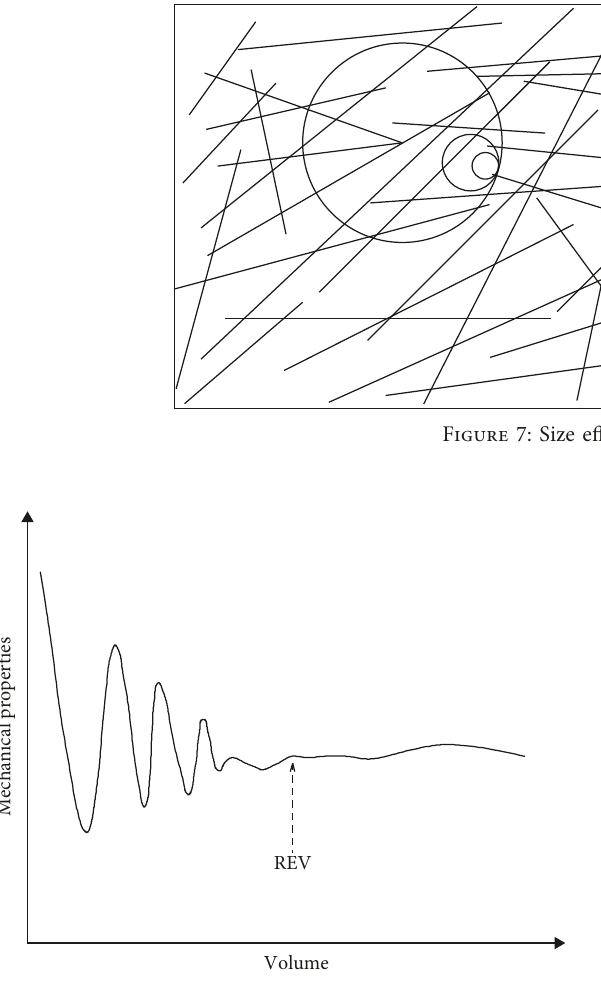
Figure 8: Representative elementary volume